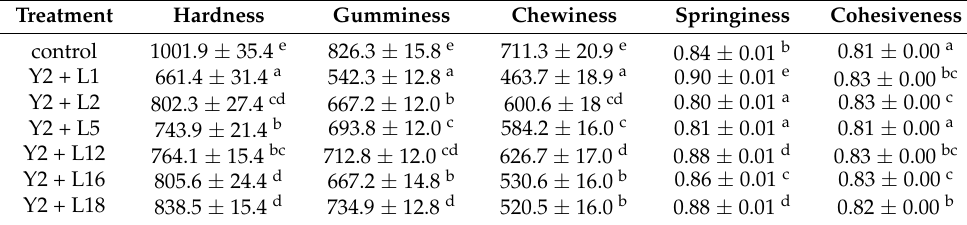
Table 3. The effects of different yeast on the texture properties of whole wheat steamed bread.